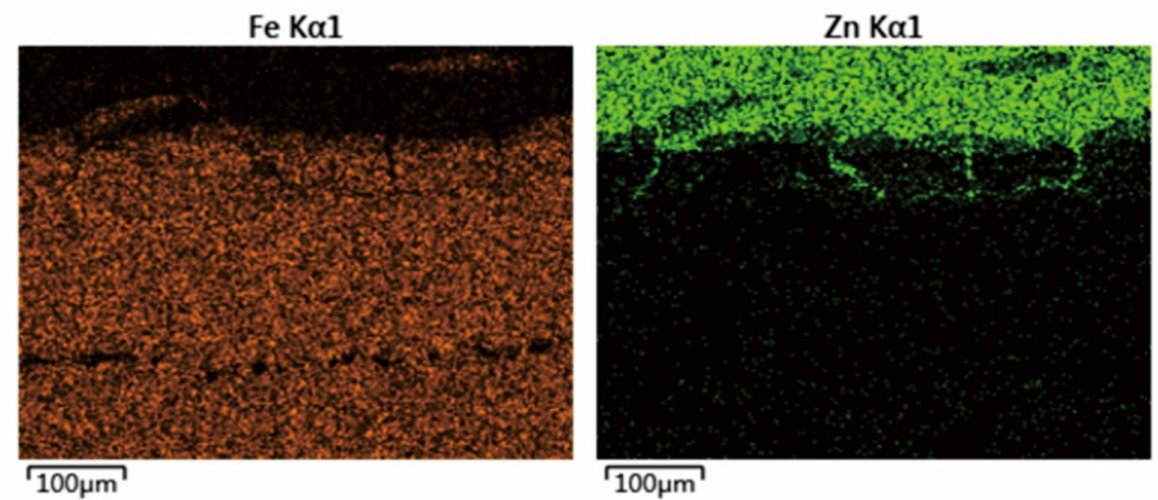
Figure 10. Area scanning analysis of Fe and Zn of the coating immersed in liquid zinc for 3